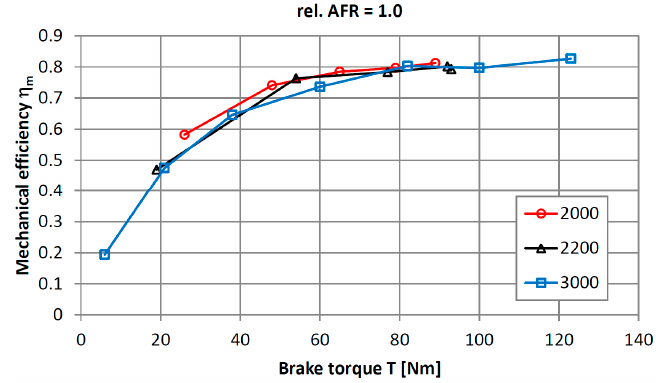
Figure 14. Mechanical efficiency as a function of the load for three different values of the rotational